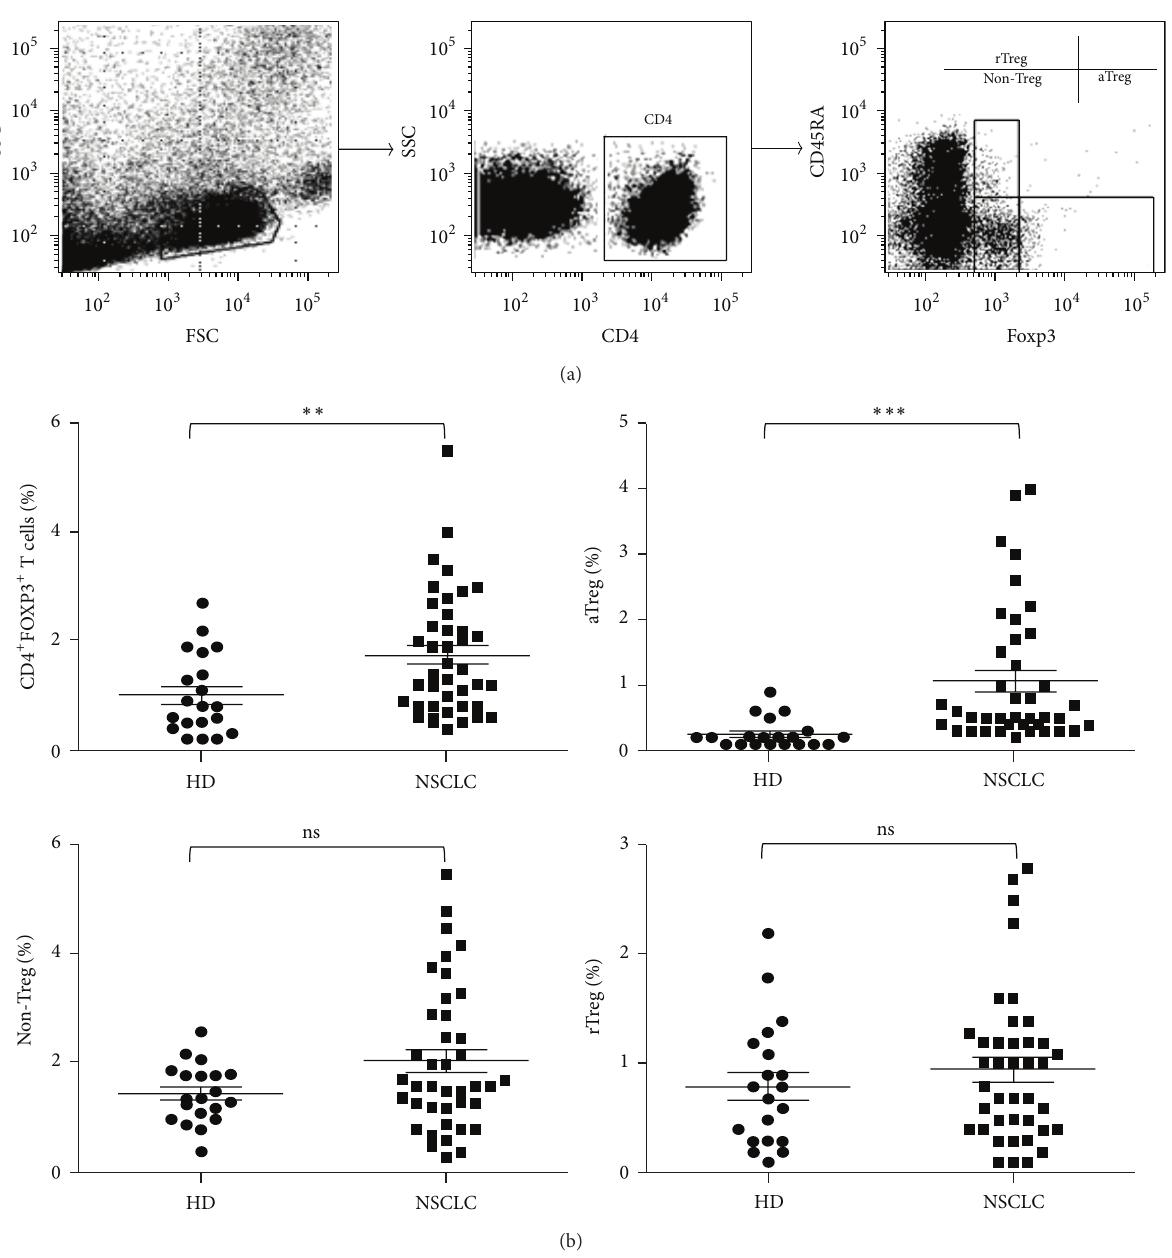
Figure 1: aTreg but not rTreg and non-Treg cells increased in NSCLC patients. (a) CD4 + Foxp3 + T cells and three subsets of Treg cells from PBMCs were isolated and analyzed by FACS. (b) The percentages of Treg cells (CD4 + Foxp3 + T (total Treg) cells, CD4 + CD45RA − Foxp 3 hi (aTreg) cells, CD4 + CD45RA − Foxp 3 lo (non-Treg) cells, and CD4 + CD45RA + Foxp 3 lo (rTreg) cells) in CD4 + T cells were calculated after FACS analysis. HD: healthy donor, 𝑛 = 20 ; NSCLC: nonsmall cell lung cancer, 𝑛 = 40 . Each dot represents one individual sample. ∗∗ 𝑃 < 0.01 and ∗∗∗ 𝑃 < 0.001 for statistical analysis by Student’s 𝑡